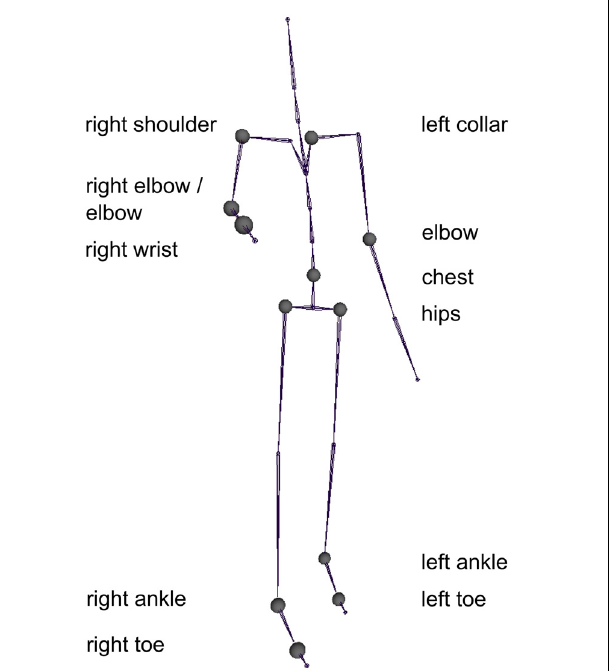
FIGURE 6 | d (cid:2) values adjusted for mean RT of the behavioral experiment (dotted lines and crosses) and the predicted d’ performance from the regression model (solid circles).